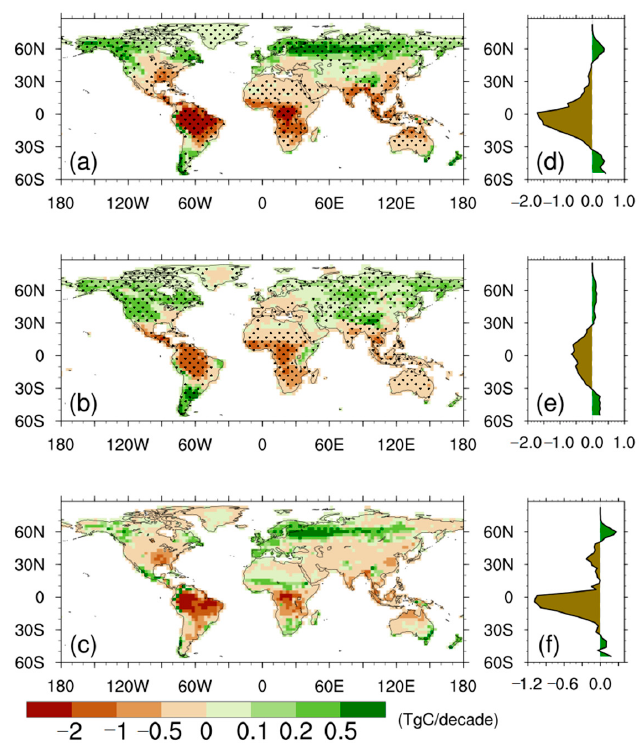
Figure 6. Spatial distribution of trends in NPP anomalies for ( a ) the CAS-ESM2, ( b ) multi-model ensemble, and ( c ) the differences. The stippled regions represent regions with statistical significance ( p < 0.001). ( d – f ) correspond to the zonal averages. All units are TgC decade − 1 .